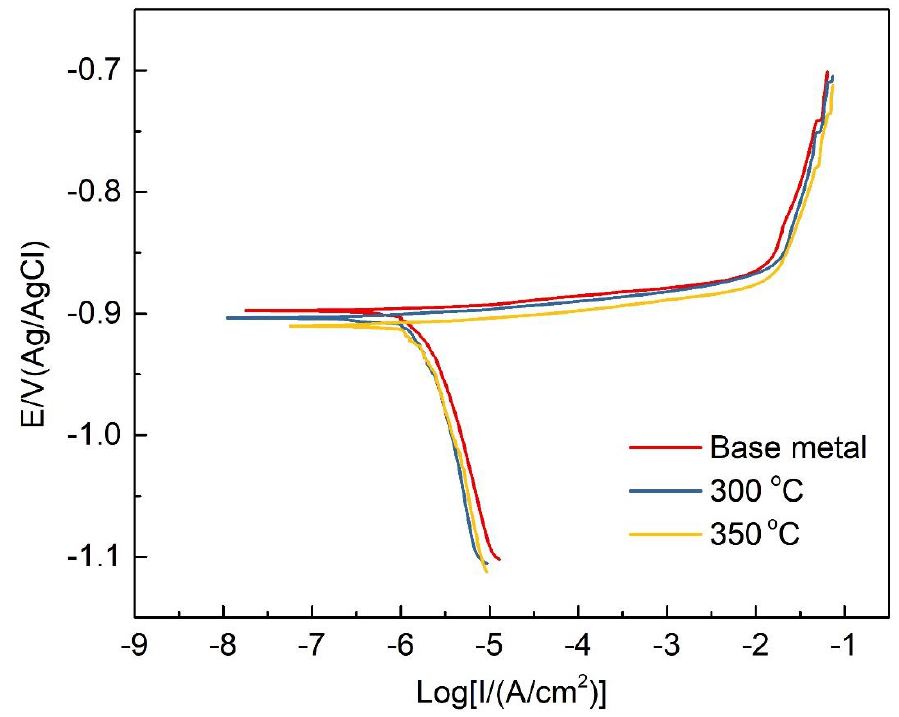
Figure 9. Potential dynamic polarization curves of 7N01 aluminum alloy in a 1 M NaCl aqueous solution under di ff erent heat treatment solution under different heat treatment conditions. Table 3. Electrochemistry corrosion parameters of 7N01 aluminum alloy in a 1 M NaCl aqueous solution.